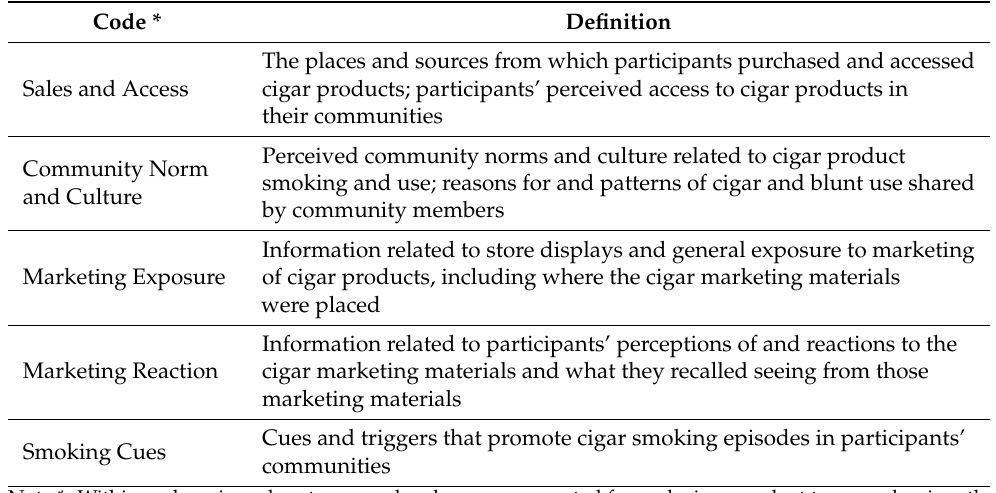
Table 1. Codebook Used for Identifying and Analyzing Themes Emerging from Interviews.